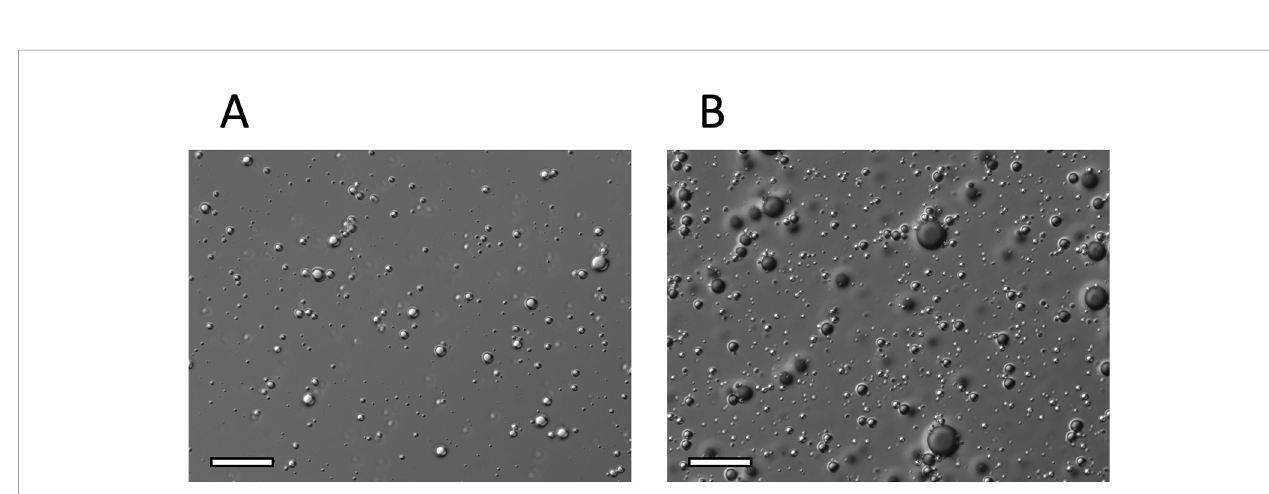
FIGURE 6 | Representative DIC microscopy images (x 63) of (A) , NO-OFP-MB 9:1 v/v, and (B) , NO-OFP-MB 1:1 v/v. Scale bar = 20 µm. NO-OFP-MB, Nitric oxide and octa fl uoropropane microbubbles.